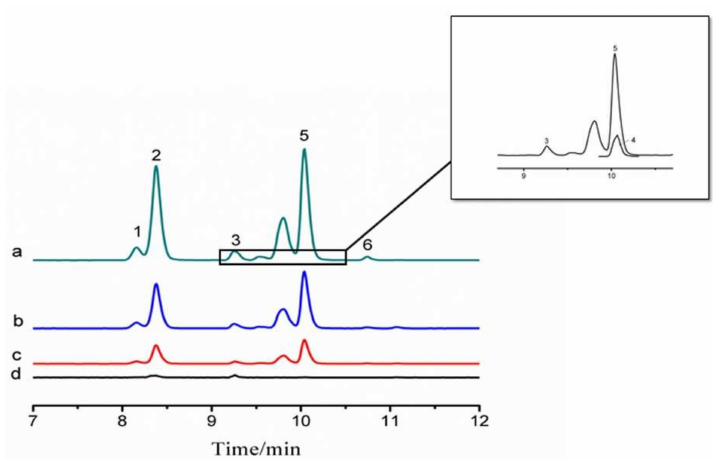
Figure 3. Typical chromatograms of the six PFAAs in real water samples. Pond water spiked at: (a) 100; (b) 50; and 20 ng/L (c); and pond water (d). (1) PFHpA; (2) PFHxS; (3) PFOA; (4) PFNA; (5) PFOS; and (6)